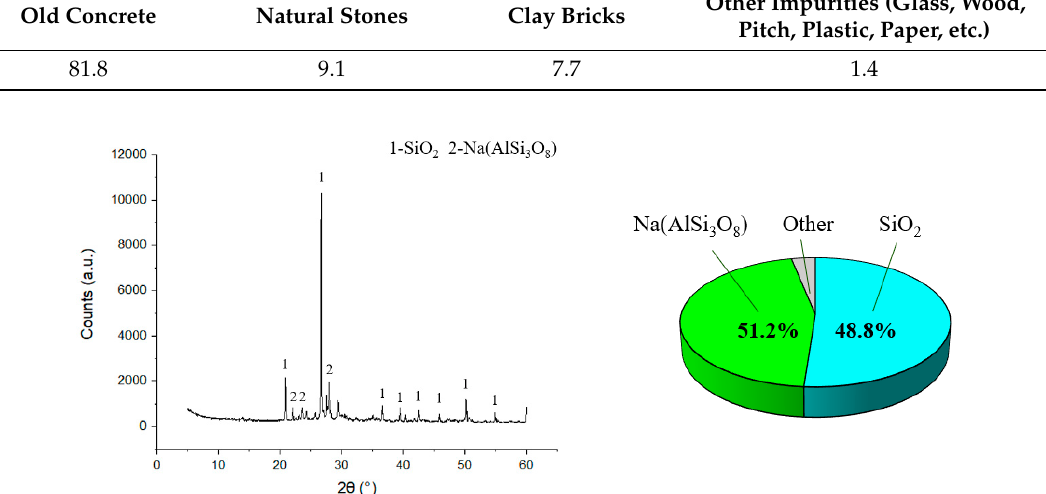
Figure 3. Phase composition of recycled aggregate.